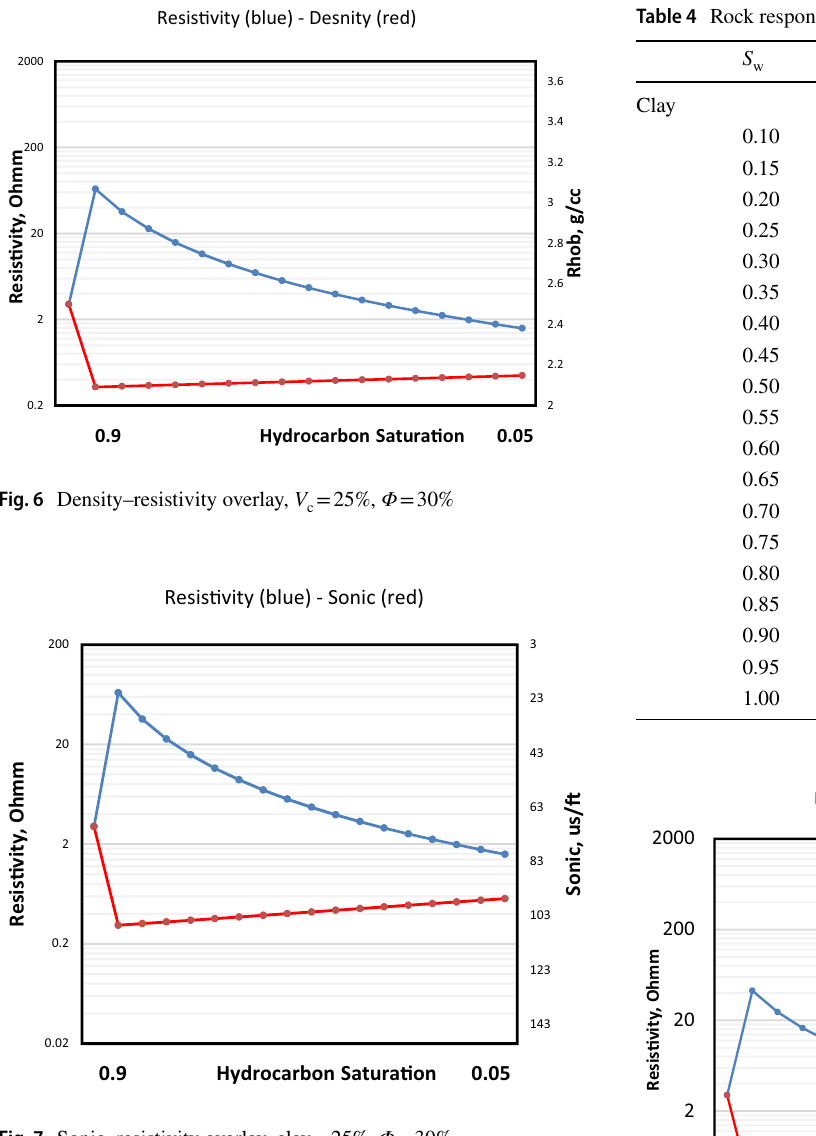
Fig. 7 Sonic–resistivity overlay, clay = 25%, Φ = 30%